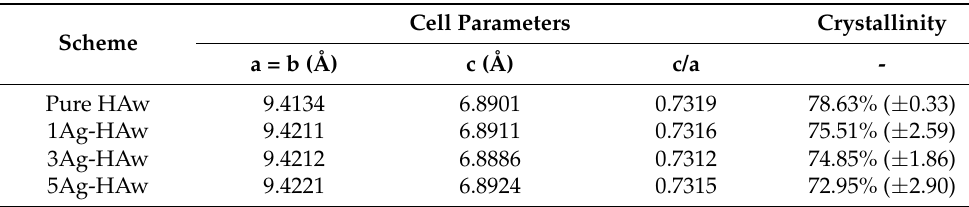
Figure 1. SEM micrographs of Ag/HAw-nmZnO with different amounts: ( a ) pure; ( b ) 1Ag-HAw; ( c ) 3Ag-HAw; ( d ) 5Ag-HAw ( e ) ZnO/3Ag-HAw; ( f ) mapping of ZnO/3Ag-HAw; ( g ) 5Ag-HAw TEM and SAED patterns; ( h ) pure HAw TEM and SAED patterns. Table 2. Lattice parameters and crystallinity of the sample.